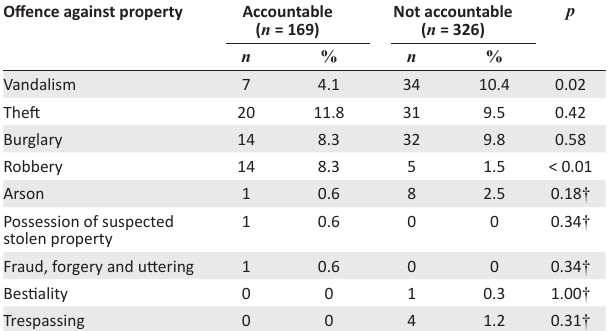
TABLE 5: Offences committed by observati against properties. Offence against property